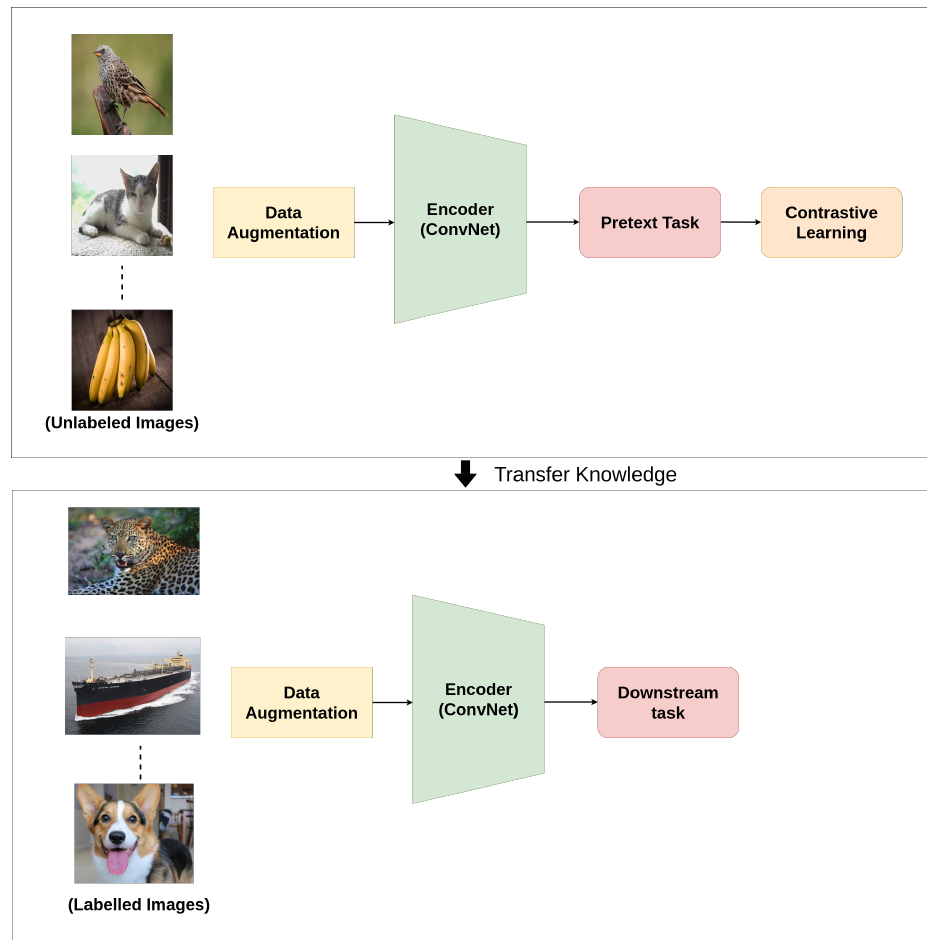
Figure 16. An overview of downstream task for images.